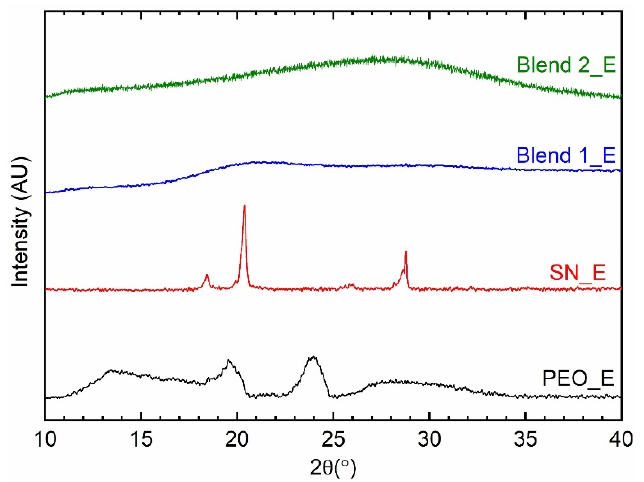
Figure 4. XRD patterns of the solid redox mediators, SN_E, PEO_E, Blend 1_E, and Blend 2_E.